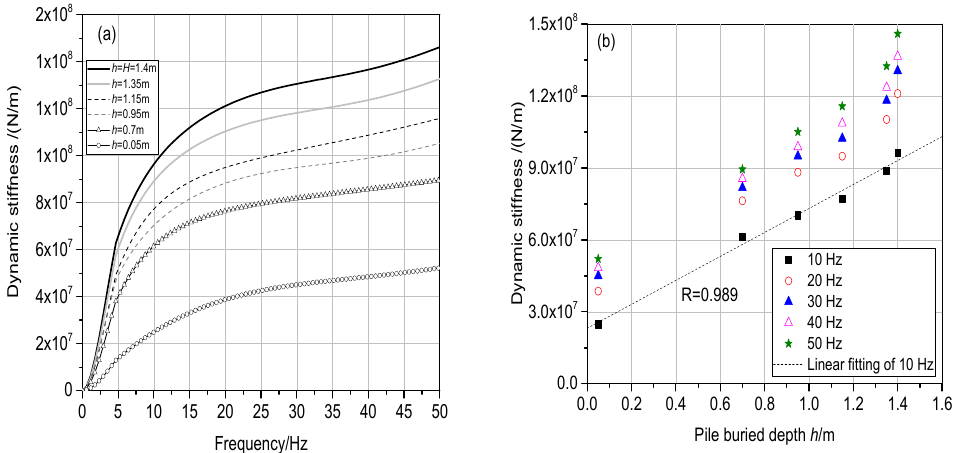
Figure 15. Dynamic stiffness changes for various pile buried depths for model P1: ( a ) K d ( f ) function; and ( b ) K d values at 10, 20, 30, 40, and 50 Hz.